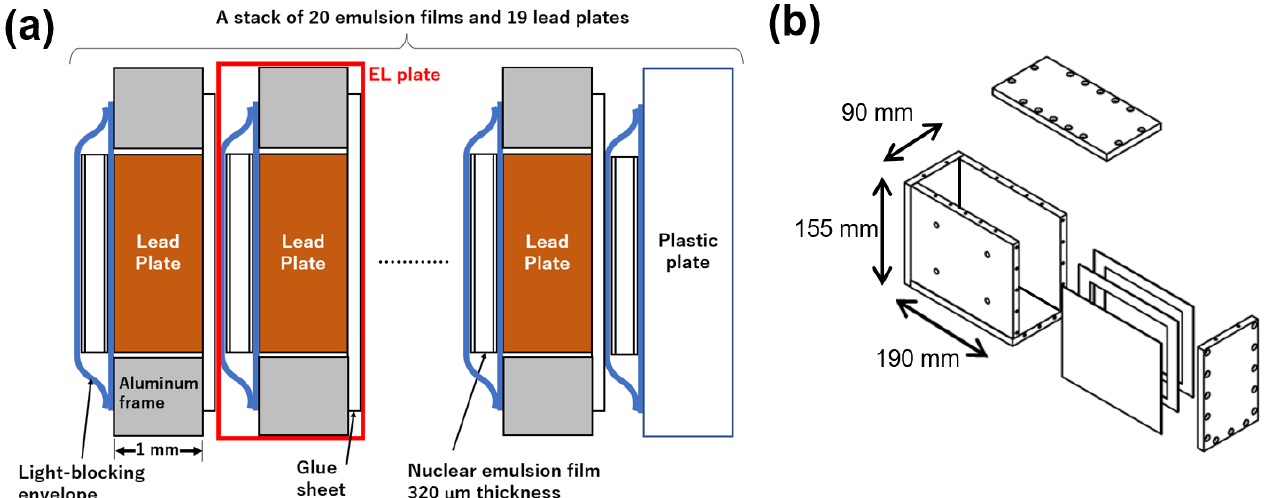
Figure 2. Design of the ECC and outer box. (a) Schematic cross-section of the EL plates and an ECC. The EL plates consist of a 1mm thick aluminum frame, 1mm thick lead plate, 100µm thick glue sheet that fixes a lead plate to an aluminum frame, and an emulsion film with a light-blocking envelope. An ECC consists of 19 EL plates and an emulsion film with a plastic plate. (b) Schematic of the aluminum outer box. The thickness of the aluminum plate is 10mm. The ECC shown in (a) was set inside this box. There are four holes for feed screws in the front plate.